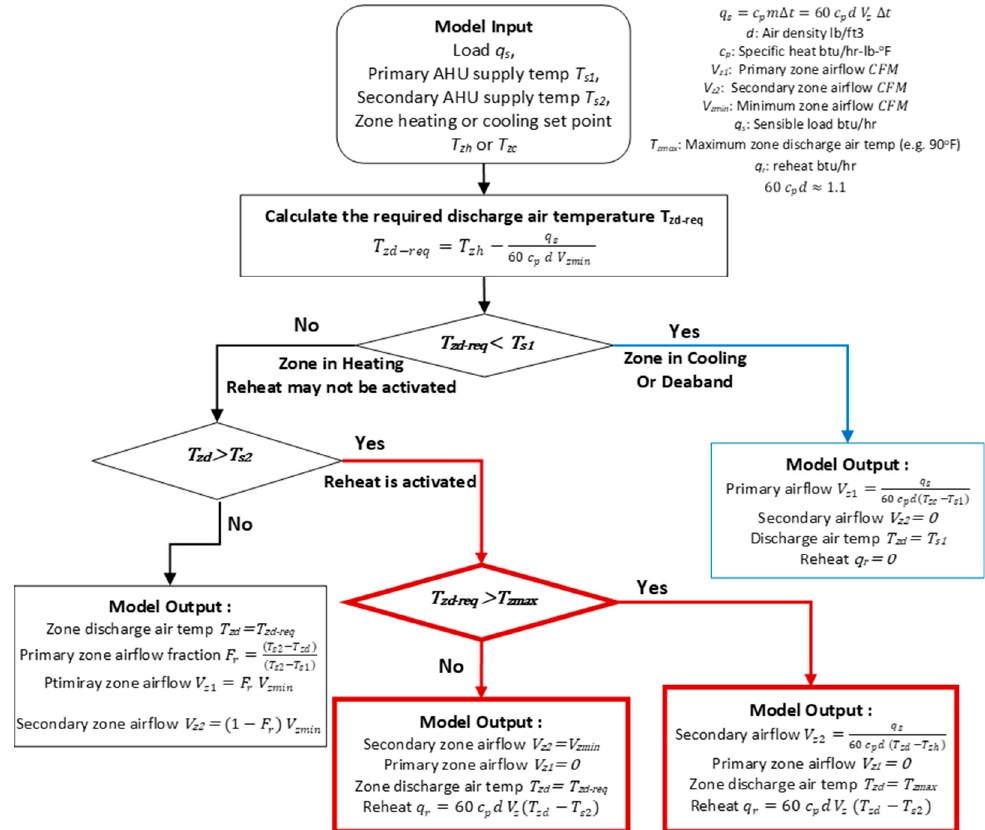
Figure 6. Zone modeling strategy used for dual VAV boxes.